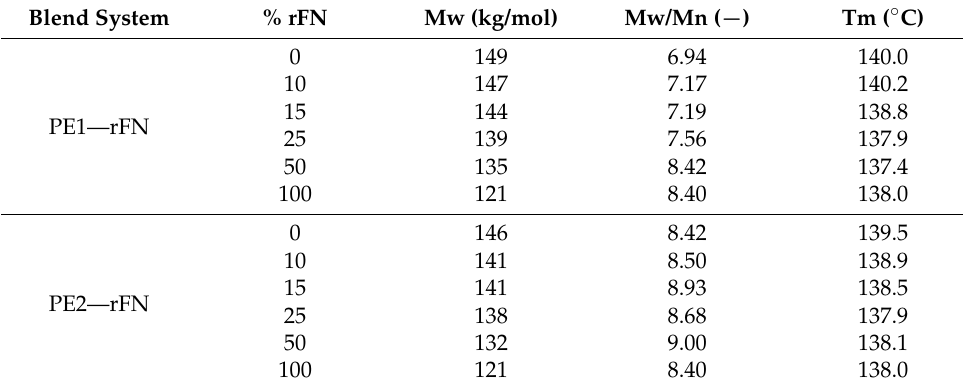
Table 2. GPC and DSC results for PE1—rFN and PE2—rFN blend systems. Blend System % rFN Mw